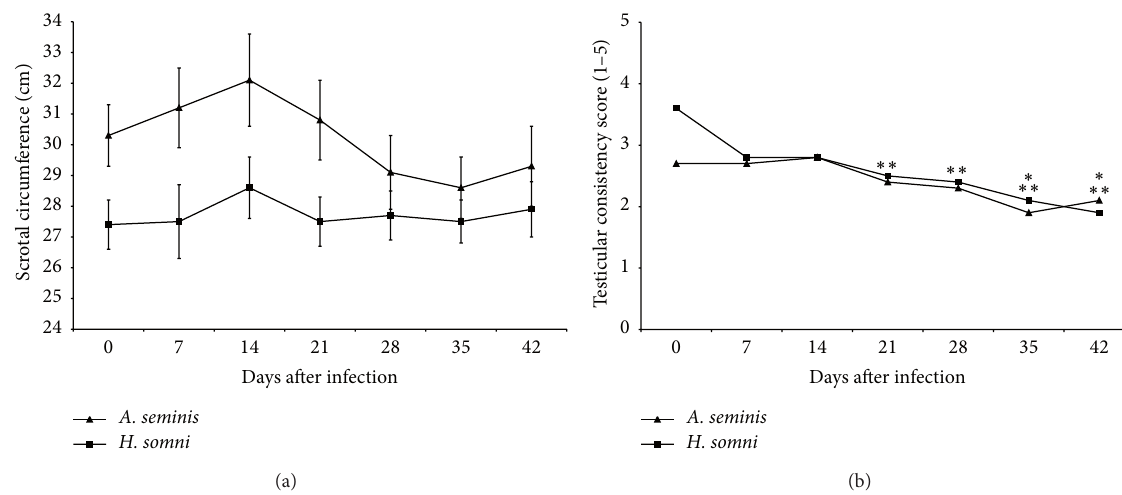
Figure 1: Testicular parameters of rams experimentally infected with Actinobacillus seminis ( 𝑛 = 10 ) or Histophilus somni ( 𝑛 = 10 ) during 42 days of infection. (a) Scrotal circumference. The values of each point represent the average and standard error. (b) Testicular consistency. The values of each point represent the mean. Asterisks indicate statistical difference ( 𝑃 < 0.05 ) when compared to preinfection values (time 0) by Dunn test for multiple comparisons ( ∗ A. seminis ; ∗∗ H. somni ).